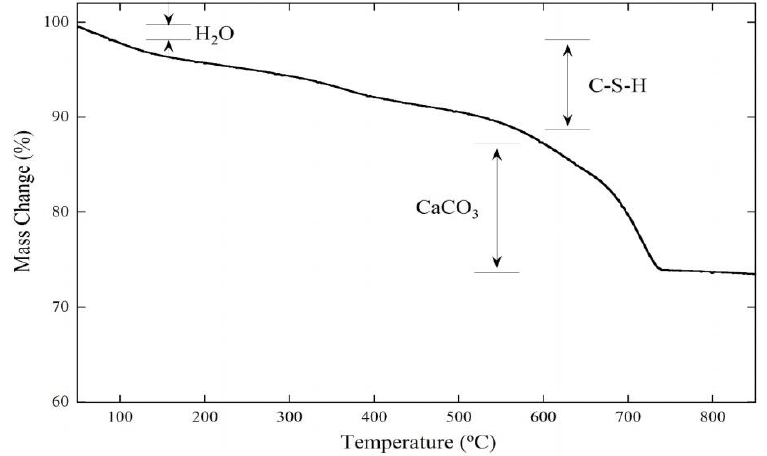
Figure 2. Thermogravimetric analysis (TGA) results of as-received waste slate. “H